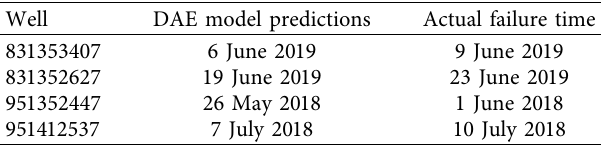
Figure 12: Detection of pump damage time of well 951412537 by DAE. Table 6: Comparison between ESP anomaly detection time and actual failure time by DAE